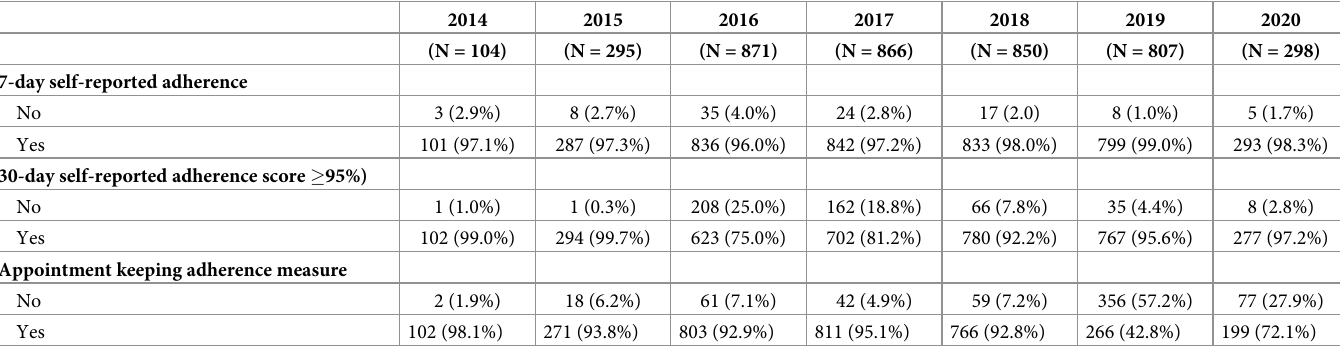
Table 2. ART Adherence measures (7 and 30 self-reported adherence and appointment keeping during